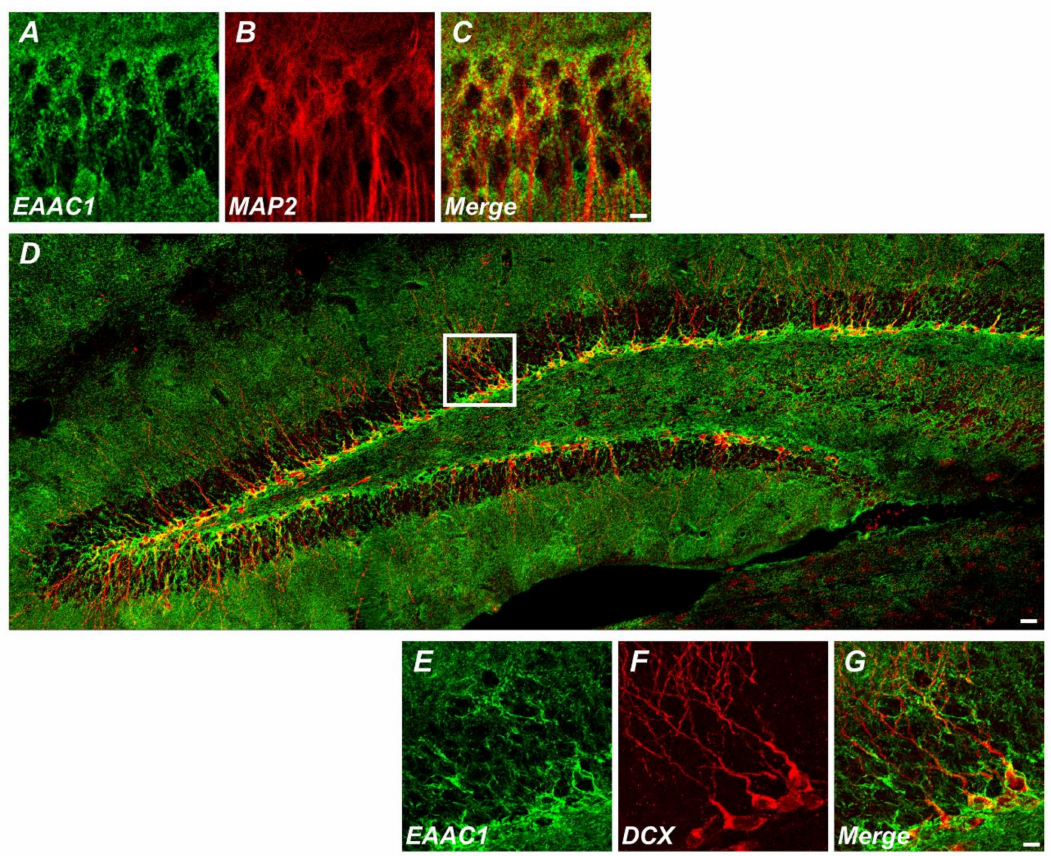
Figure 1. Excitatory amino acid carrier 1 ( EAAC1 ) is expressed in immature neurons as well as mature neurons. ( A – C ) Immunofluorescence images representing the expression of EAAC1 - ( A ) and MAP2-immunopositive cells ( B ) and EAAC1 / MAP2 double-positive cells ( C ) in the hippocampal CA1 of wild-type (WT) mice (3–5 months old; weight 25–35 g). Scale bar = 5 µ m. ( D – G ) Double-label confocal micrographs of EAAC1 (green) and doublecortin (DCX) (red) in the hippocampal dentate gyrus (DG). Scale bar = 20 µ m. ( E – G ) Higher magnification of the white box in D showing the expression of EAAC1 - ( E ), DCX-immunopositive cells ( F ), and EAAC1 / DCX double-positive cells ( G ) in the subgranular zone / glutamate-cysteine ligase (SGZ / GCL) of DG. Scale bar = 5 µ